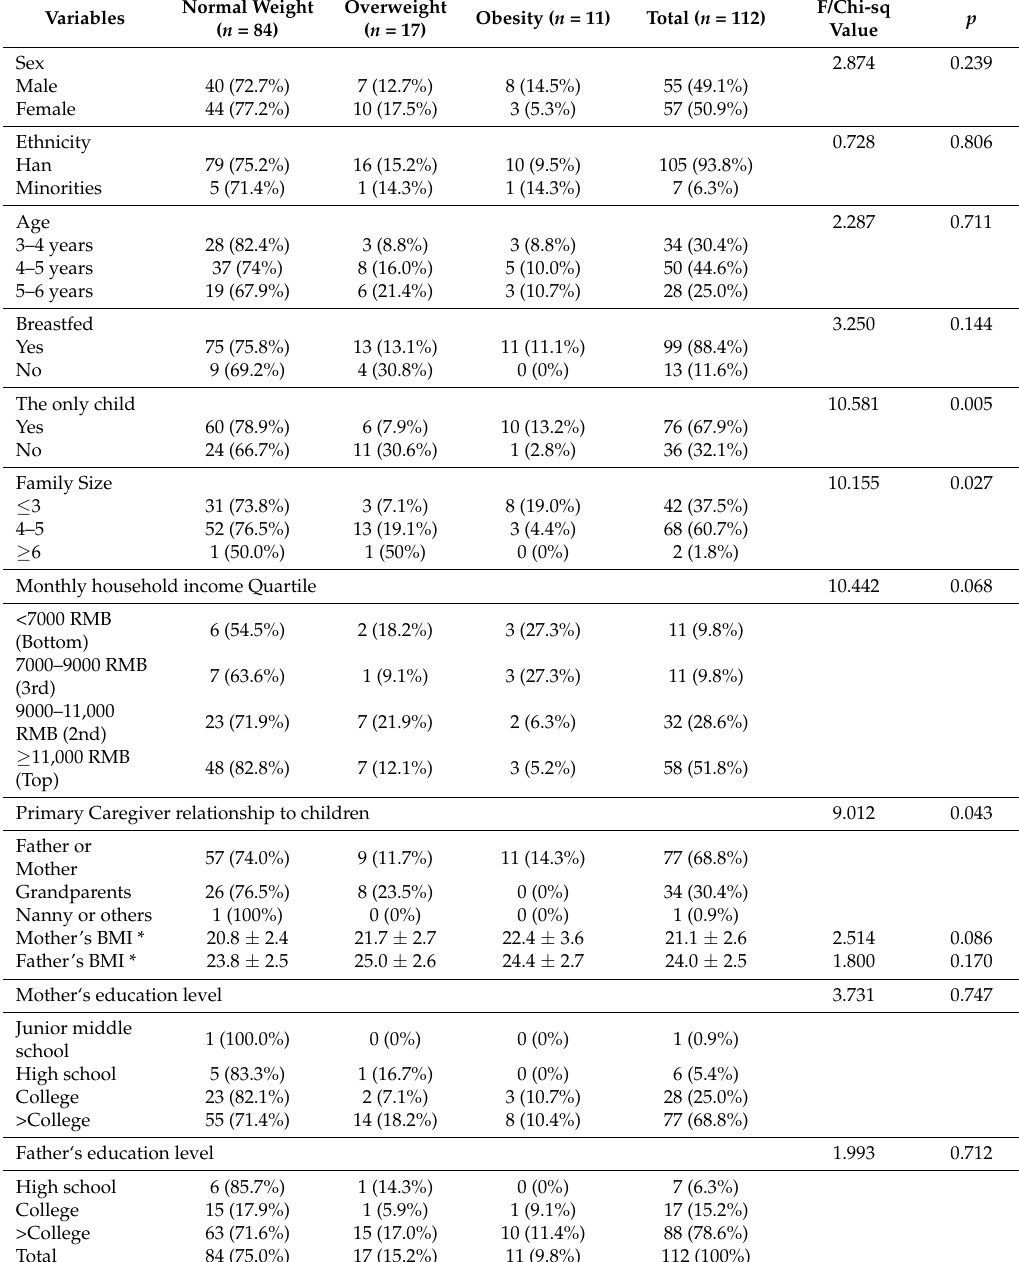
Table 1. Socio-demographic characteristics of study population ( n ,